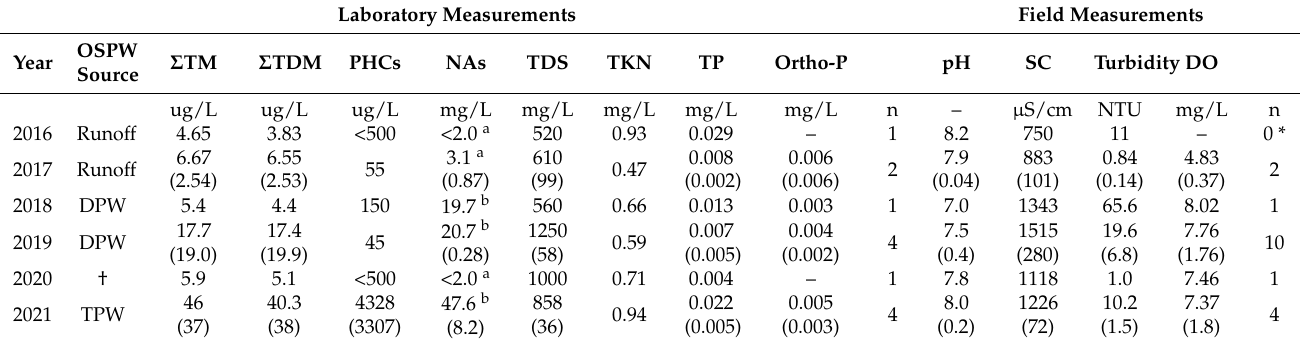
Table 1. Water quality parameters for OSPW in the Kearl Treatment Wetland from samples collected prior to the vegetation assessments in 2016–2021. Standard deviation in brackets where